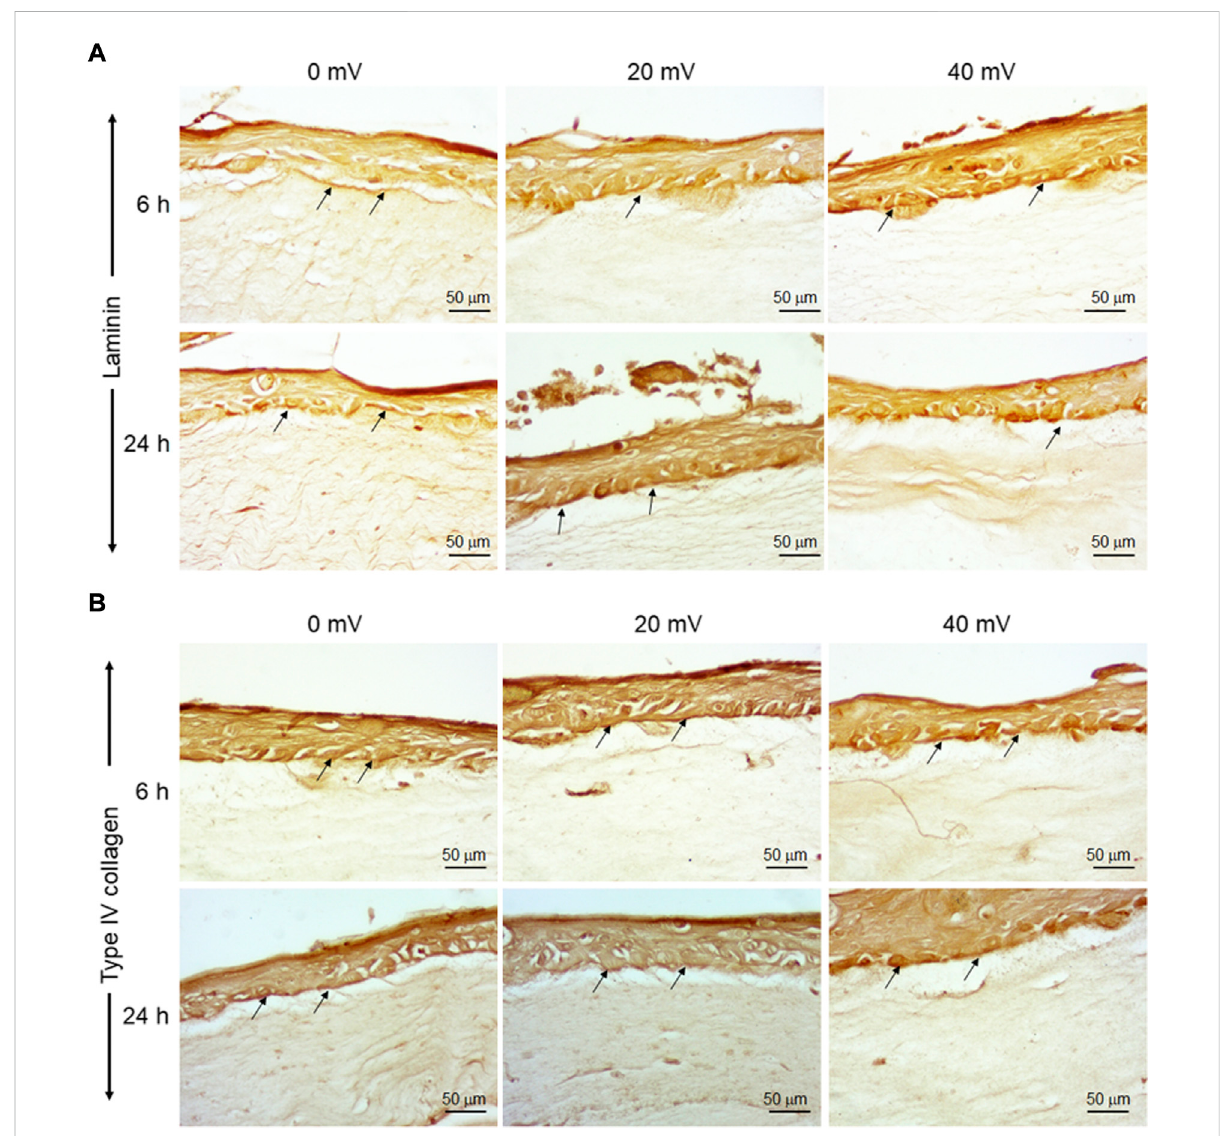
DepositionoflamininandTypeIVcollagenatthebasementmembraneofDHSE.AfterthetissueengineeringandexposuretoESfor6and24 h, the presence of laminin and Type IV collagen proteins were evaluated by immunohistochemistry, as described in the M&M. Panel A shows Laminin- stained tissues. Panel B shows Type IV collagen-stained tissues. Arrows point out stained proteins. ( n =